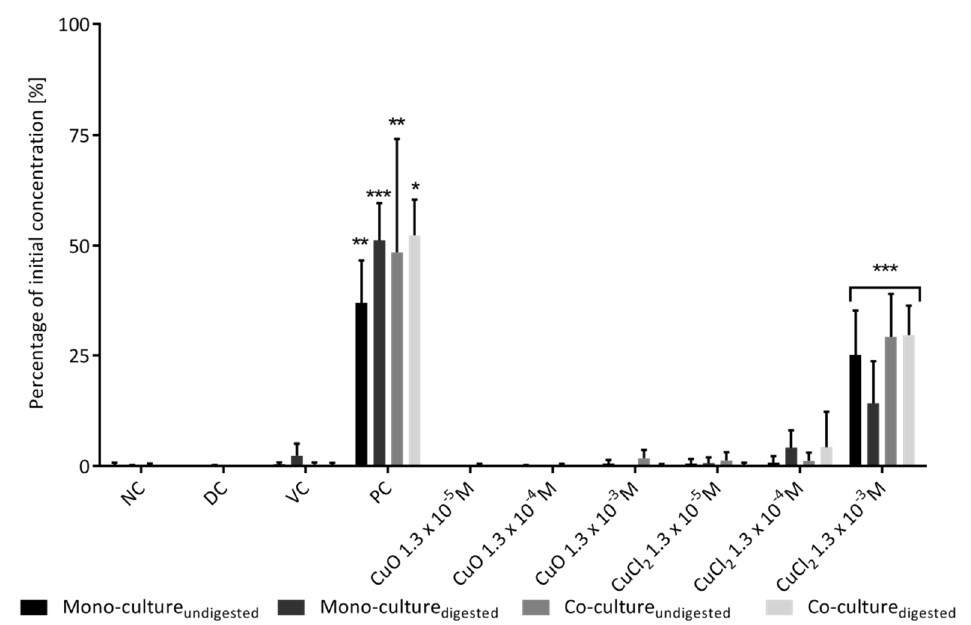
Figure 4. Permeability of the monolayers of Caco-2 mono-culture and Caco-2/HT29-MTX co-culture cells after incubation with digested and undigested copper oxide nanoparticles. The FITC-dextran concentrations after 24 h were normalized to the initial applied FITC-dextran concentration in the apical compartment, which was determined by incubating a Transwell insert without cells with FITC-dextran and measuring the basolateral concentration after 24 h. NC: negative control (cell culture medium); PC: positive control (10 mM EGTA and 0.1% Triton-X-100); DC: digestion control (10% digestive juice in culturing medium); VC: vehicle control (0.05% BSA solution). The statistical differences relative to NC are marked as: * p < 0.05, ** p < 0.01 and *** p < 0.001. The error bars represent the standard deviation of four independent measurements.